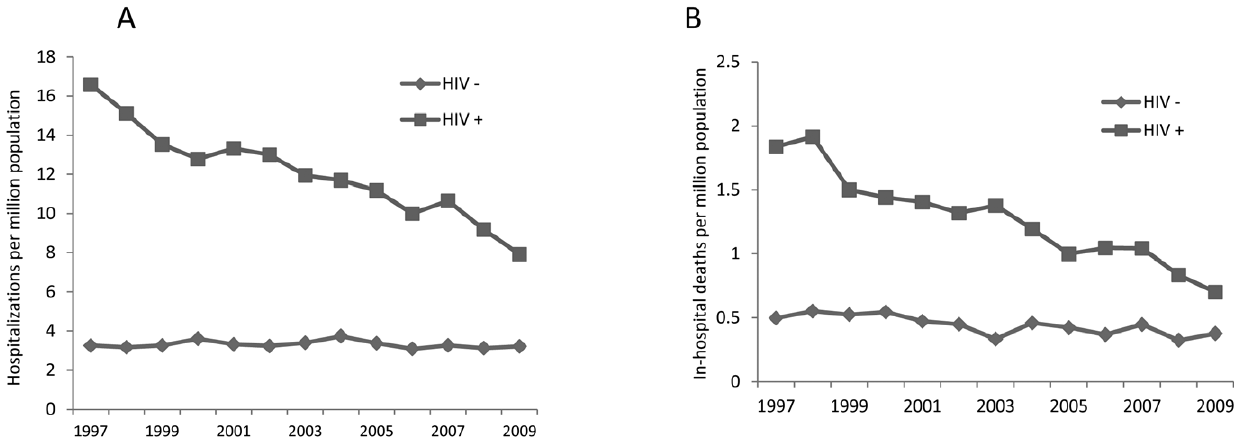
Figure 2. Hospitalizations for CM in the US. A) Hospitalization for CM per million population in HIV-infected and HIV-uninfected patients. B) In hospital mortality per million population in HIV-infected and HIV-uninfected